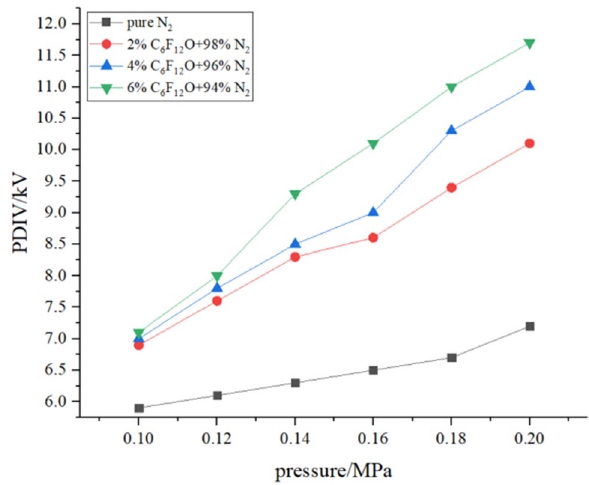
Figure 5. PDIV with the pressure.